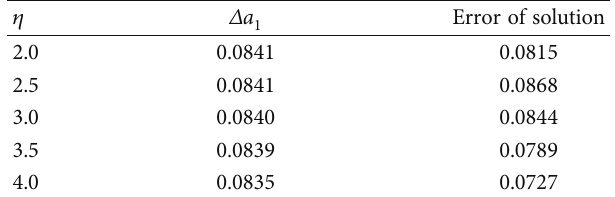
and error of solution. 1